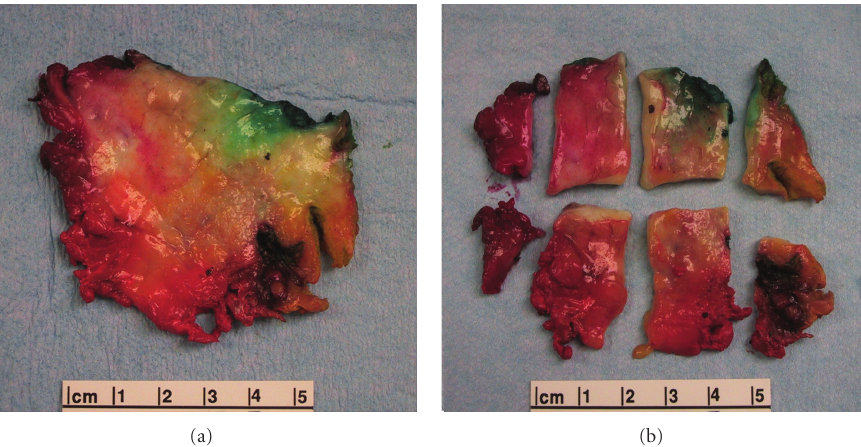
Figure 1: Each tissue slice will generate anywhere between 6 and 10 standard sections depending on the size. In this example of a slice measuring 6cm in the largest dimension we created 8 generous standard sections.